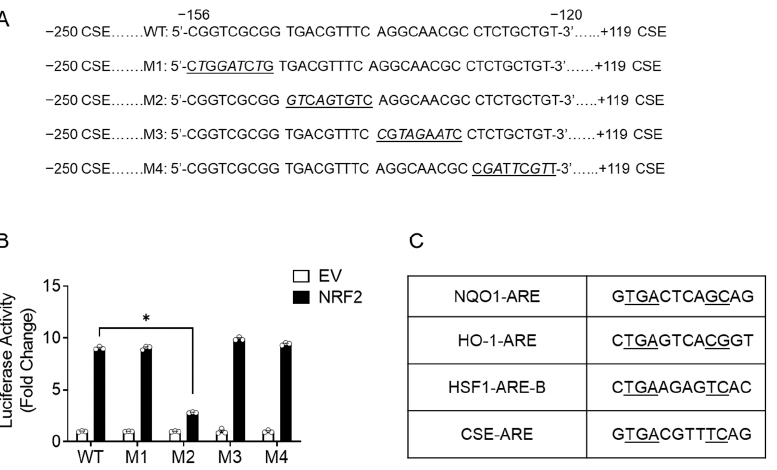
Figure 4. Effects of site mutations in the CSE promoter sequence on NRF2-inducible activity. Schematic representation of the CSE promoter site mutation constructs. Numbering is relative to transcription initiation site. Four segments of nine nucleotides for each of the 36 base pair regions of the CSE promoter comprised between nt − 156 and − 120 were mutated separately (mutation sites shown in italic underlined) ( A ). iSAE cells were co-transfected with the wild type (WT) − 250-CSE-PGL4-Luc or the site mutants (M1 to M4) and Renilla-Luc plasmid plus either the empty vector or the NRF2 expression vector and harvested 48 h later to measure luciferase activity. Luciferase activity was normalized to Renilla luciferase activity. Results are expressed as mean ± SEM of triplicate determination of a representative experiment repeated twice and expressed as fold change relative to empty vector (each circle represents individual data). * p < 0.05 relative to WT PGL4-Luc ( B ). Nucleotide comparison of putative CSE antioxidant response element (ARE) with canonical (NQO1) and non-canonical (heme oxigenase-1, HO-1 and HSF1) ARE sites ( C